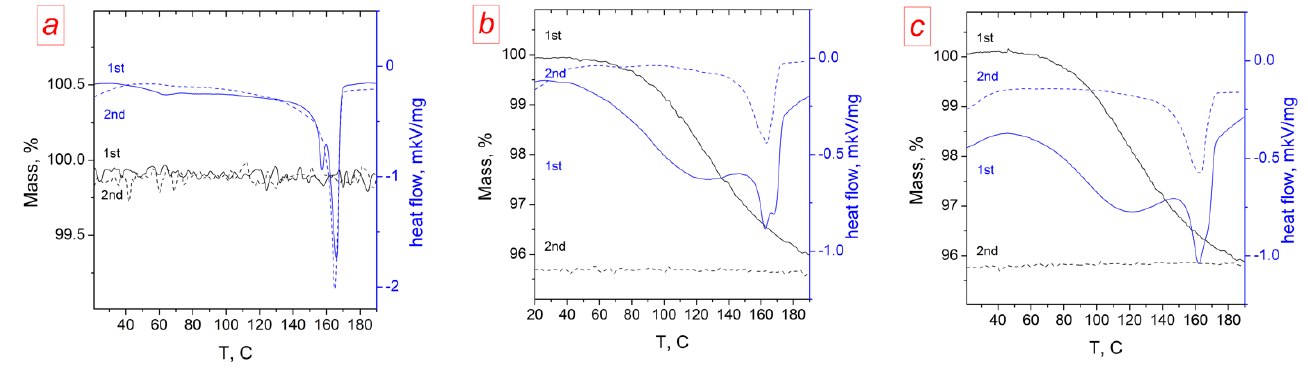
Figure 4. DSC curves of three-stage heating–cooling–heating analysis for the studied samples: ( a ) PVDF, ( b ) MCG-0, and ( c ) MCG-3. The curves for the first and second heating are shown. Table 2. Data regarding the quantitative analysis of the thermograms of the second heating cycle.